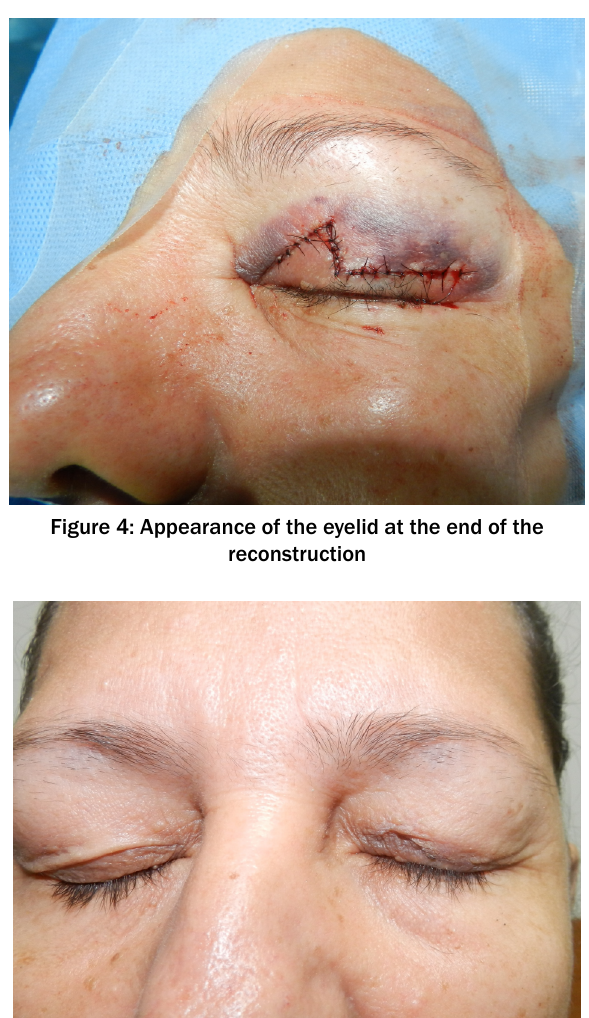
Figure 5: Three-week follow-up